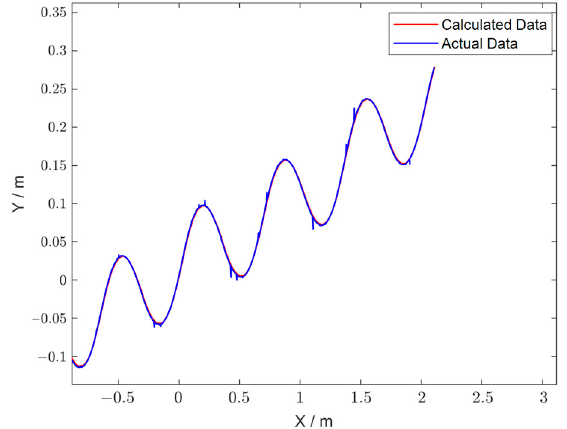
Figure 4. Comparison between calculated position and actual position of the robot tail. Table 3. Comparison of calculated data and actual data of pose matrix.